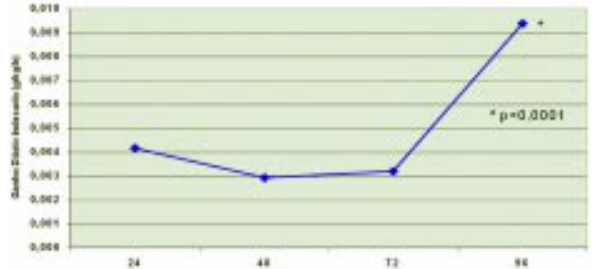
Fig. 6 - Evolução do ganho diário de massa muscular do VD (indexada para o peso corporal) ao longo do protocolo de